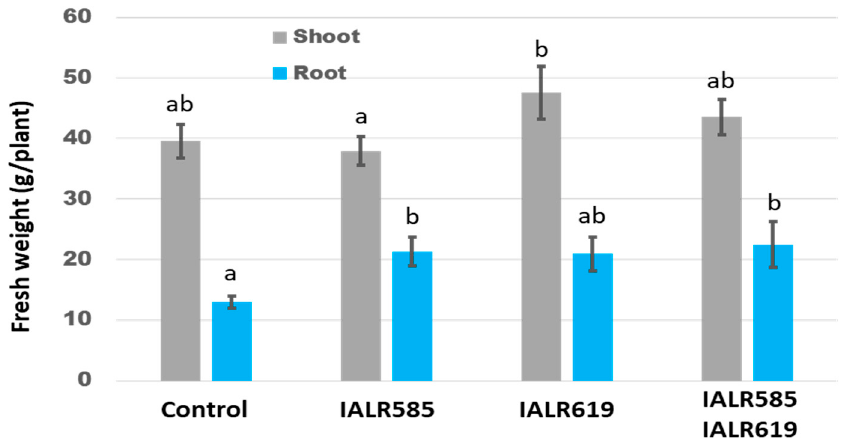
Figure 3. Effects of bacterial inoculation on strawberry shoot and root growth in the greenhouse. Different letters on bars mean significantly different at p < 0.05. The Fisher’s LSD test was used for comparing differences between treatment means. Plug strawberry plants were inoculated with bacterial cultures on 3 May 2018 and fresh weights were recorded on 9 August 2018.